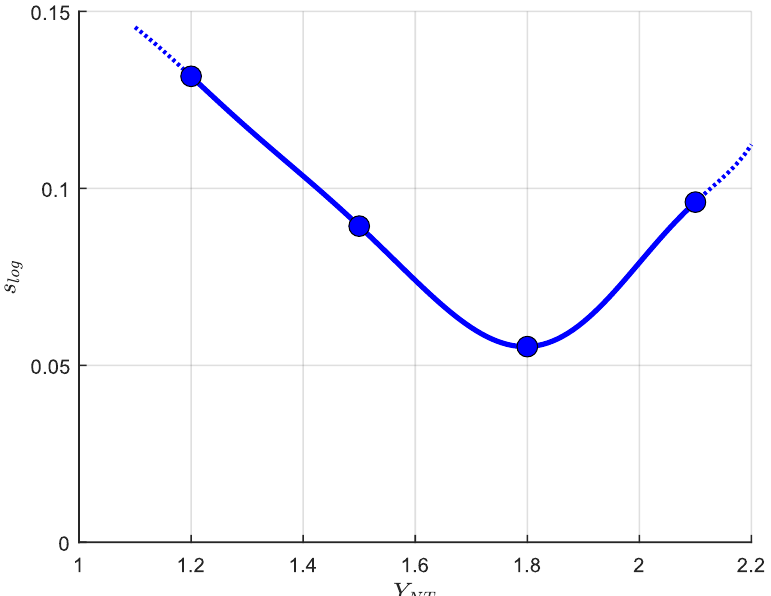
Figure 6. Logarithmic standard deviation considering failure load cycle numbers in limited-life range for peened gears according to Stahl [23].